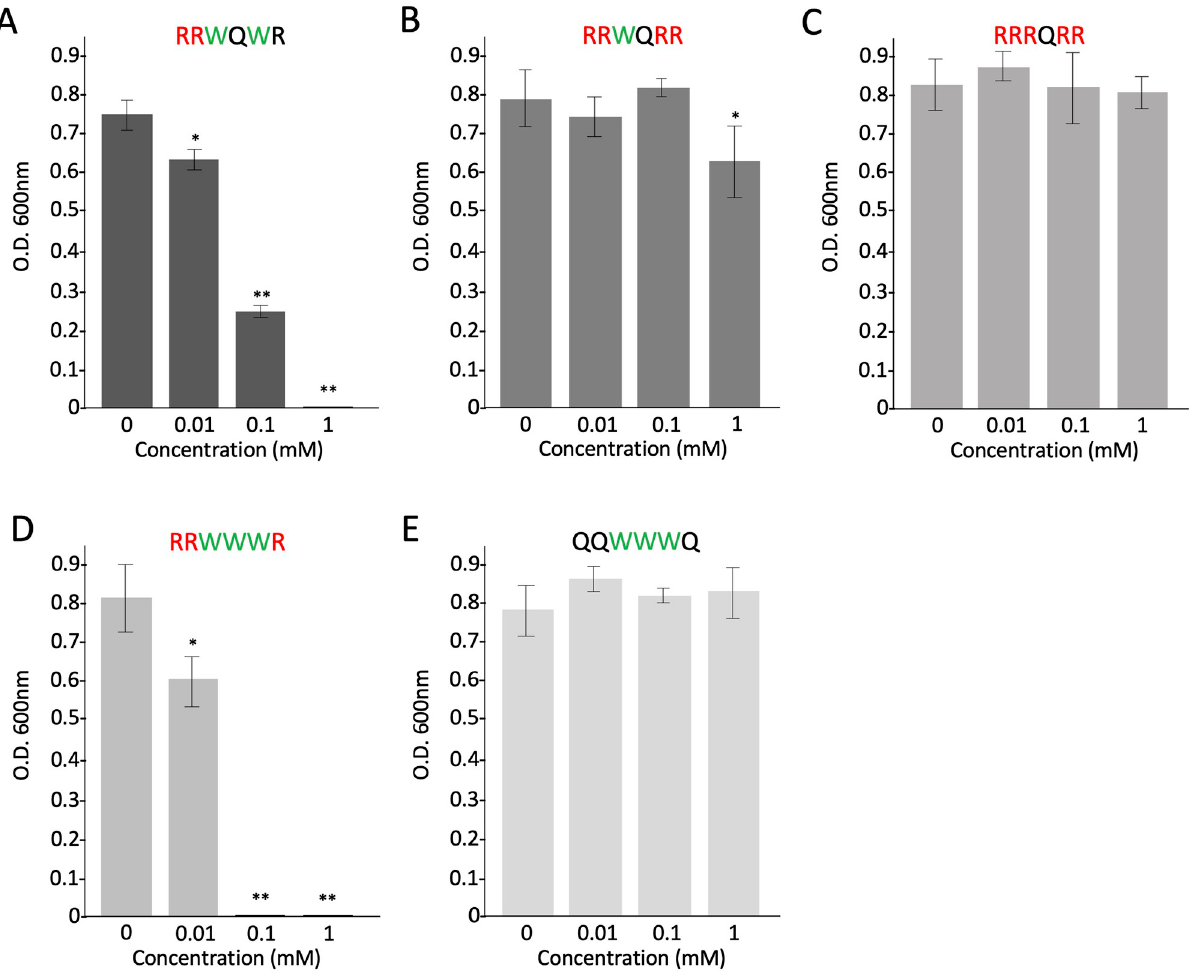
Fig 6. Antimicrobial effects of synthetic peptides on Streptomyces scabiei S58. The mixture of each synthetic peptide and spores (2 × 10 5 /mL) was incubated at 28 ˚C for 72 h in tryptic soy broth and the absorbance was measured at 600 nm to monitor bacterial growth. (A) The original sequence ( RRWQWR ) situated in bovine-derived lactoferricin. (B) RRWQRR containing only one Trp residue. (C) RRRQRR containing no Trp residue. (D) RRWWWR containing three Trp residues. (E) QQWWWQ containing three Trp residues and no Arg residue. Error bars indicate the mean ± standard division of three independent experiments. Asterisks show a significant difference with respect to the control at � p < 0.05 and �� p < 0.01 (Student’s t test).